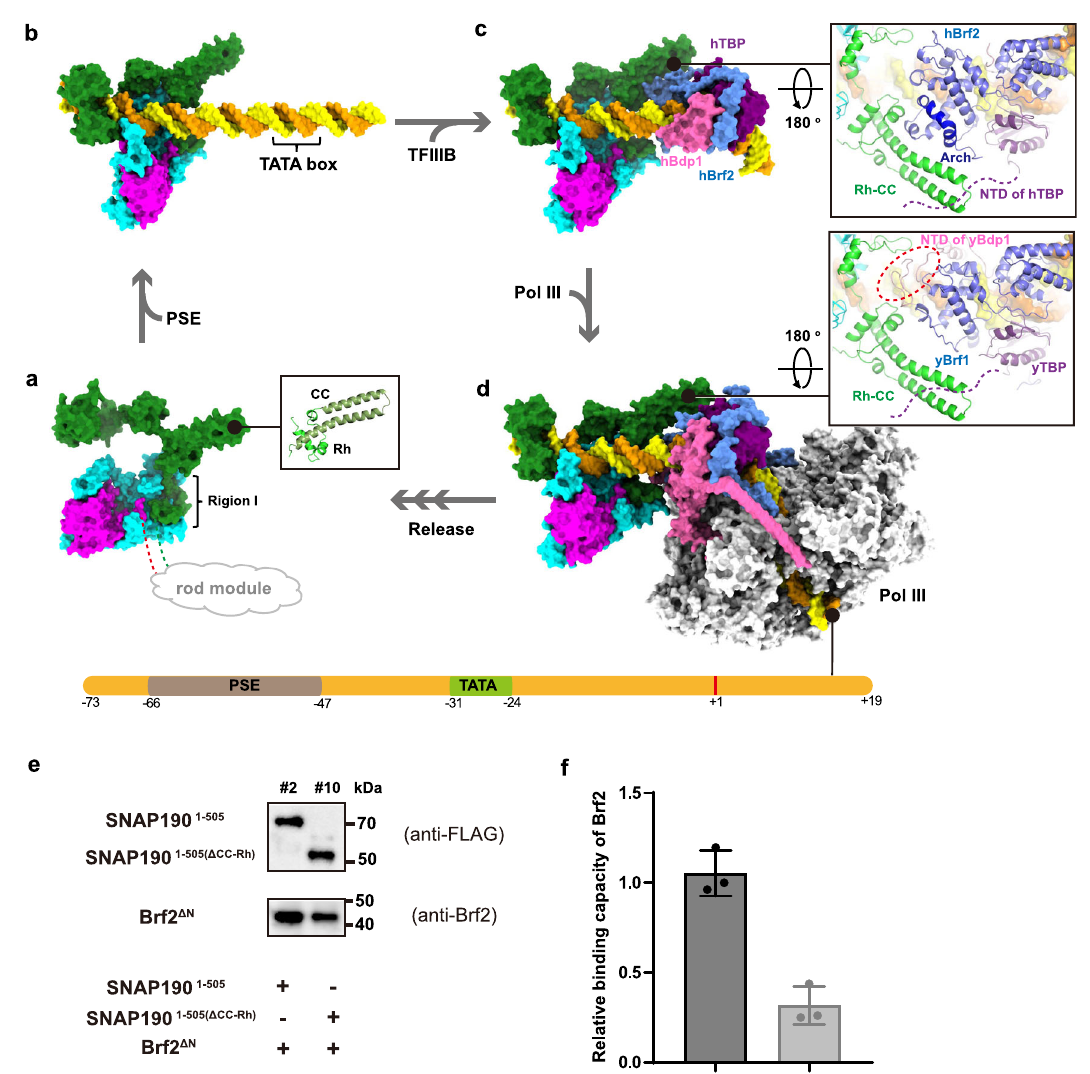
Fig.5|TheprocessofPICassemblyathumanU6 promoter.a Modelofthecore region of human SNAPc in PSE-free state. Region I of SNAP190 mediates the interactionwithSNAP50,whileotherregionsare fl exible,ofwhichtheextremeNTD interacts with the middle domain of SNAP43 and SNAP19 to form the rod module. The Rh segment and predicted CC domain of SNAP190 form a complete MYB repeat. b The structureofmini-SNAPc recognizing hU6PSE (thisstudy). c A model ofhU6promoterboundbymini-SNAPcandTFIIIB Brf2 ,inwhichthelatterspeci fi cally recognizes TATA box (PDB 5N9G). Rh-CC domain of SNAP190 could form